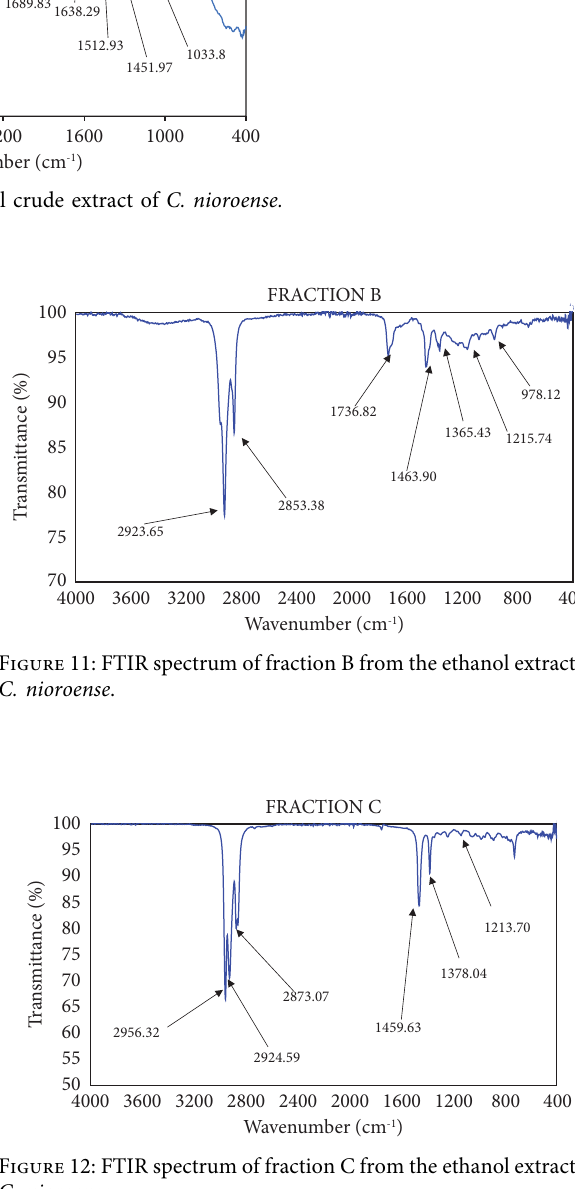
Figure 10: FTIR spectrum of fraction A from the ethanol extract of C. nioroense